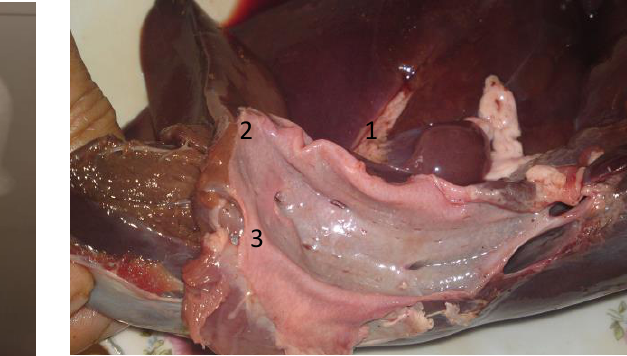
Figure, 9:The opening of hepatic vein in goat.